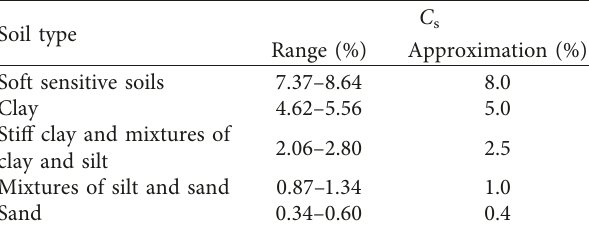
Figure 4: Schematic diagram of the unequal end area: (a) tip resistance; (b) sleeve Table 2: Shaft correlation coefficient C s [39].